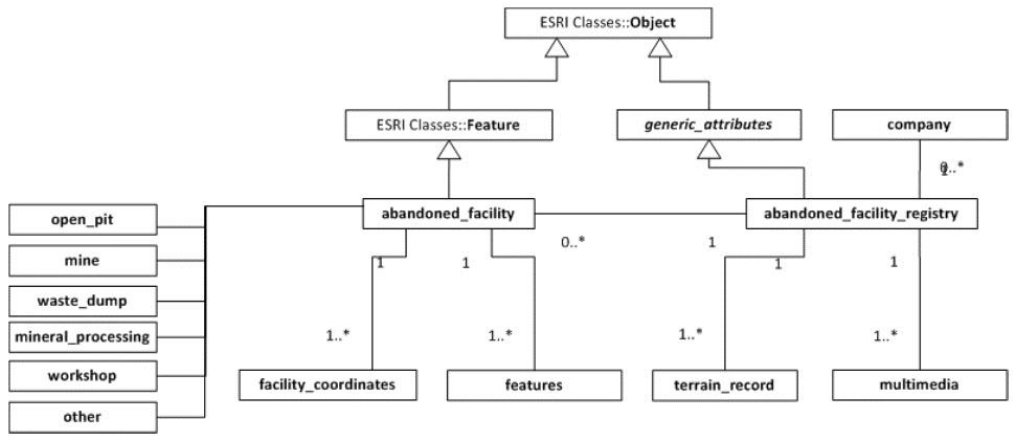
Figure 8. Characteristic part of the conceptual model. Note: 1..* stands for relation 1 to many.